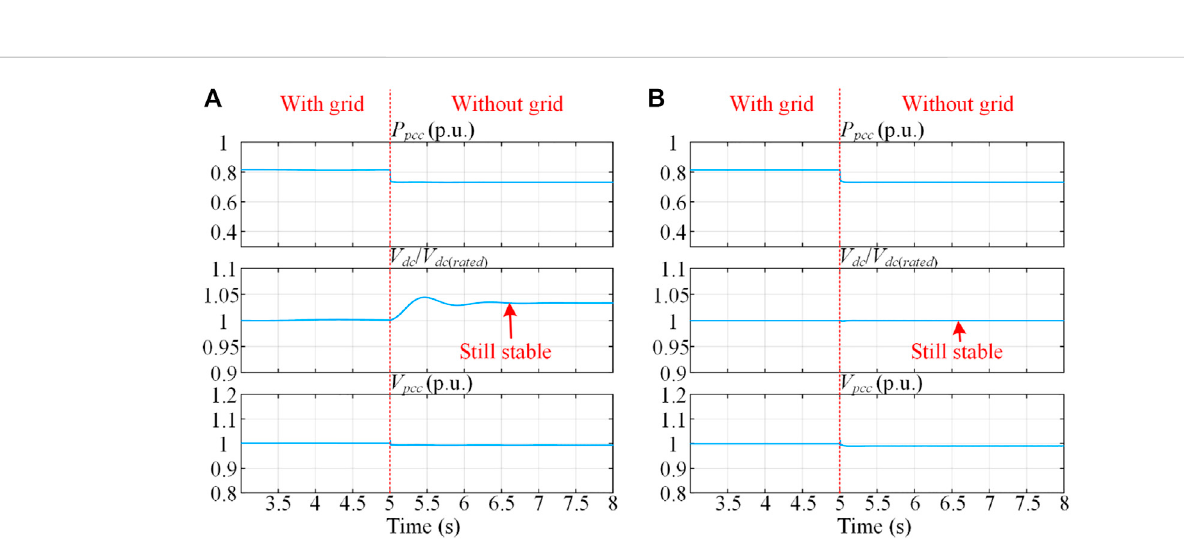
Frontiers in Energy